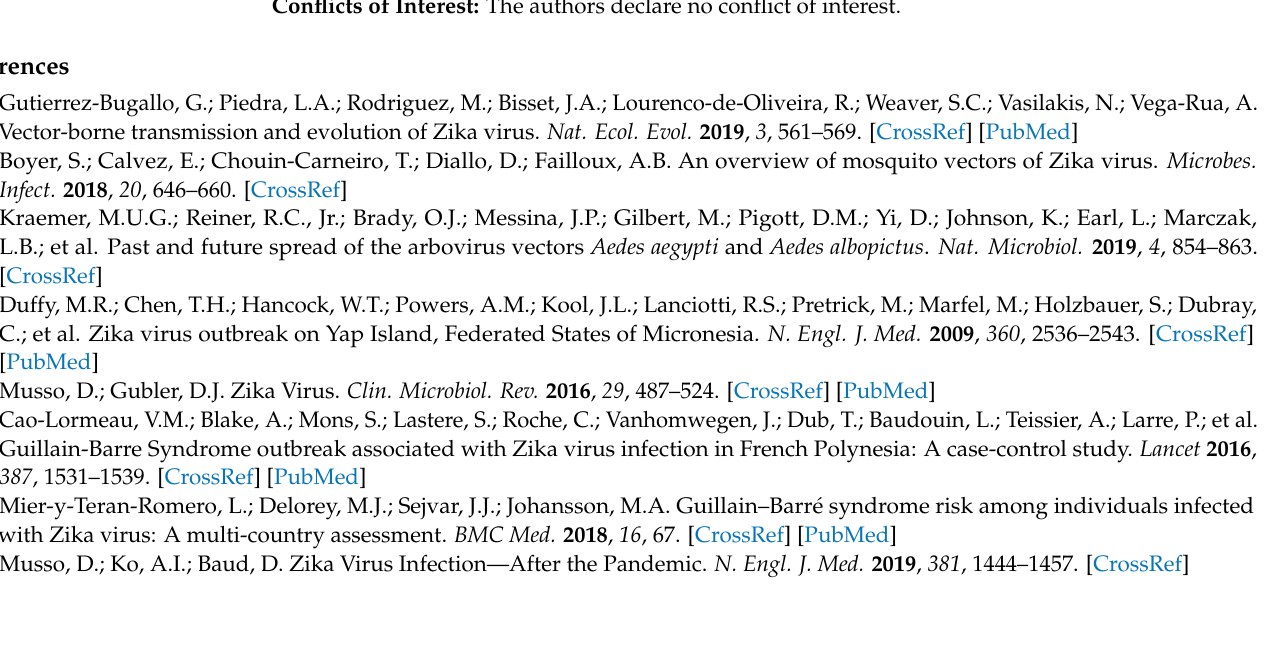
Figure S2: Effects of the combination of fluvastatin (FLU) with (a) mevastatin (MEV) and (b) simvas- tatin (SIM) on Vero cell